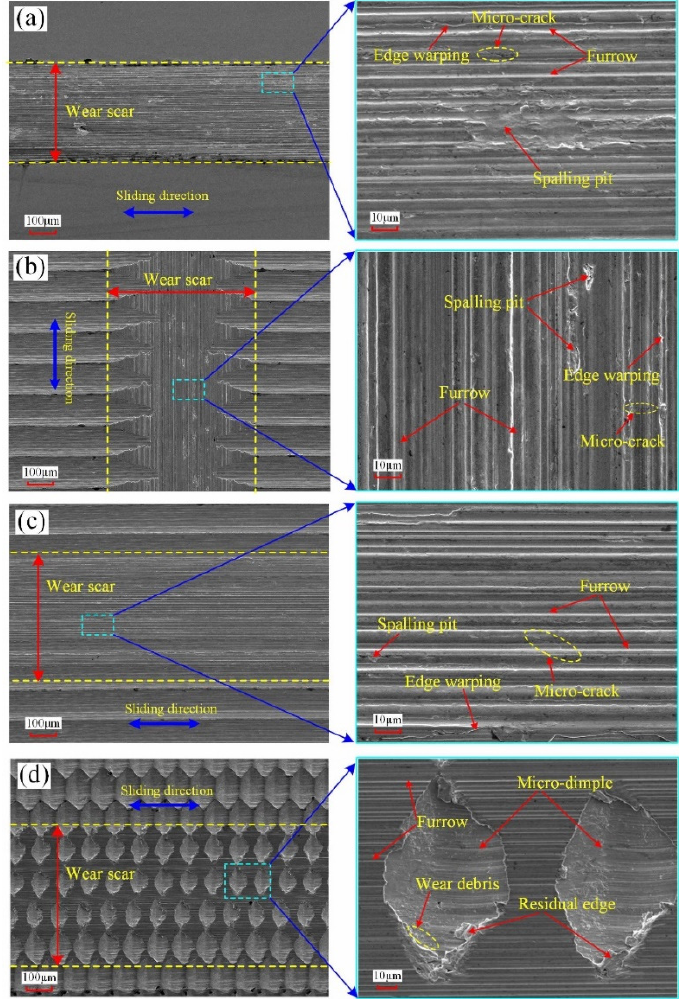
Figure 11. SEM micrographs of surface worn morphology: ( a ) surface #6; ( b ) surface #5 sliding in the feed direction; ( c ) surface #5 sliding in the cutting direction; ( d ) surface #1.